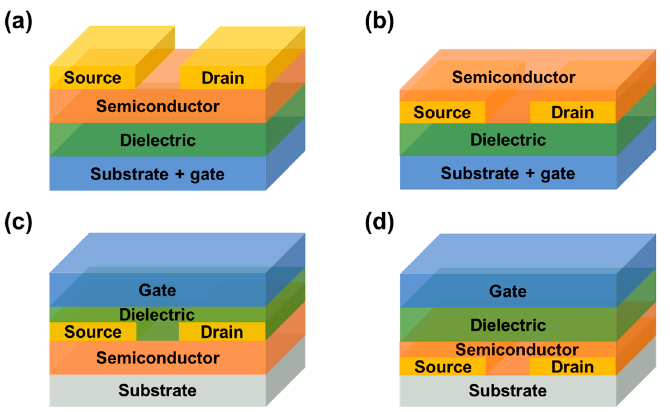
Figure 1. Schematic representation of four configurations of FETs. ( a ) Bottom − gate top contact (BGTC). ( b ) Bottom − gate bottom contact (BGBC). ( c ) Top − gate top contact (TGTC). ( d ) Top − gate (BGTC). ( b ) Bottom–gate bottom contact (BGBC). ( c ) Top–gate top contact (TGTC). ( d ) Top–gate bottom contact (TGBC). bottom contact